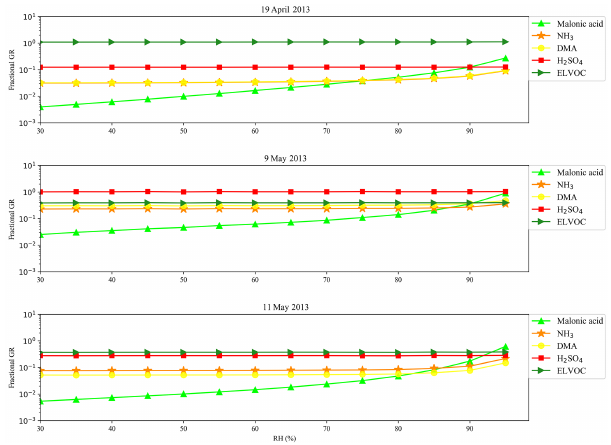
Figure 9. MABNAG prediction of growth rates of 13nm particles contributed by individual species as a function of relative humidity for three new particle formation events at